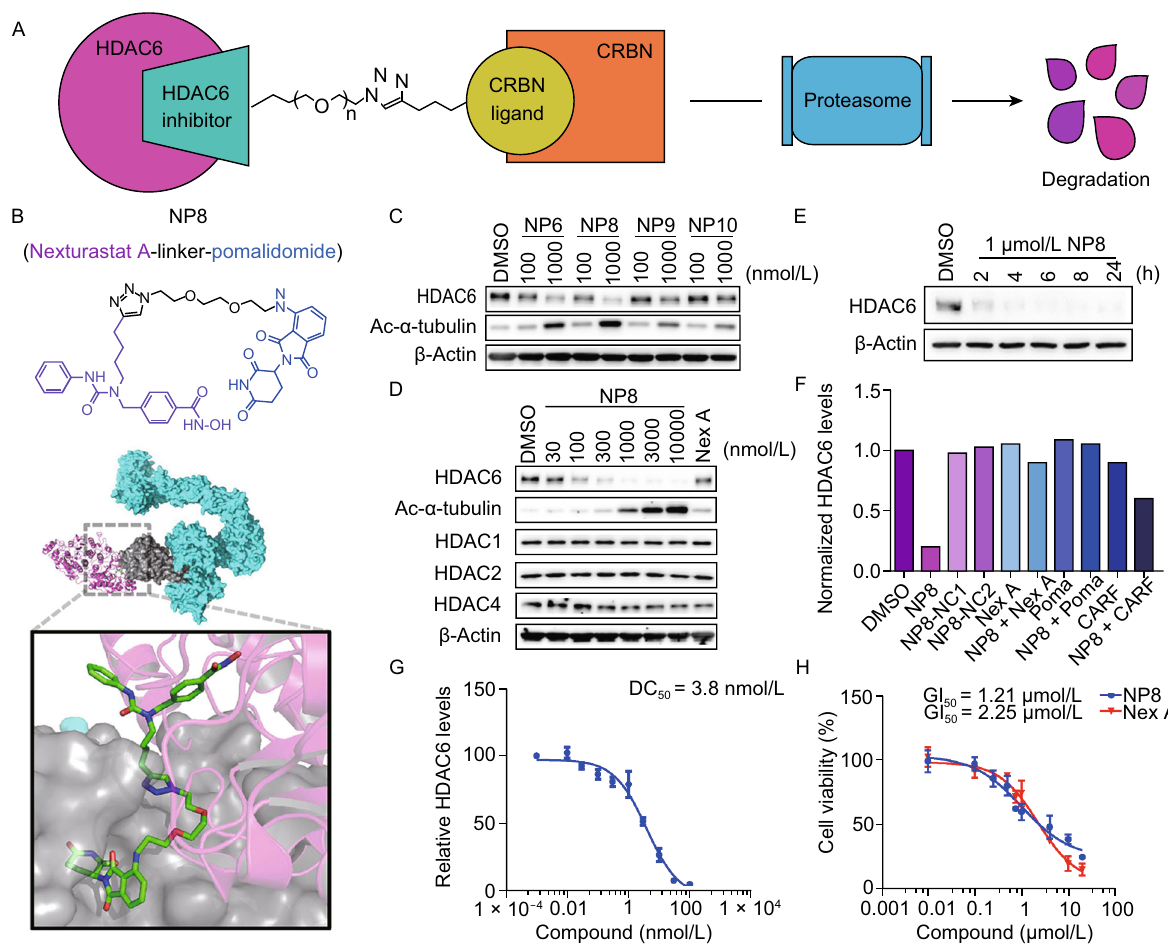
Figure 1. Development of selective HDAC6-degrading PROTACs. (A) The principle of PROTAC. (B) The structure of PROTAC, as shown in the upper portion. A binding mode of PROTAC (ball stick), HDAC6 (PDB 5G0J, purple) and CRL4-CRBN (PDB 2HYE and 4CI3, colored cyan and gray) was simulated by Pymol. (C) Screen for a potent HDAC6 degrader. HeLa cells were treated as indicated for 24 h. (D) Characterization of NP8-induced degradation in HeLa cells. The degradation of HDAC6 was in a dose-dependent manner. The HDAC1, HDAC2 and HDAC4 levels were not affected within 24 h. (E) NP8 caused fast degradation of HDAC6 within 2 h in HeLa cells. (F) NP8-NC1 and NP8-NC2 failed to degrade HDAC6. NP8 induced degradation was rescued by single introduction of Nexturastat A (Nex A, 300 nmol/L), Pomalidomide (Poma, 10 µmol/L) or Car fi lzomib (CARF, 1 µmol/L). The concentration of NP8- NC1, NP8-NC2 and NP8 were 300 nmol/L. HeLa cells were treated with Car fi lzomib for 6 h and 24 h for the rest. (G) The degradation of HDAC6 by titration of NP8 for 24 h in MM.1S cells. (H) MM.1S cells were treated with NP8 or Nexturastat A (Nex A) for 72 h. Cell viability was determined by CCK-8 assay ( n =